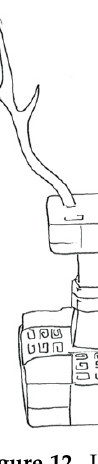
Figure 12. Line drawing of lacquered wood antler stand from Tomb 2 at Changtaiguan, Xinyang, Henan. Adapted from Henan sheng wenwu yanjiusuo (1986, pl. 110.2) courtesy of Zay Olsen.